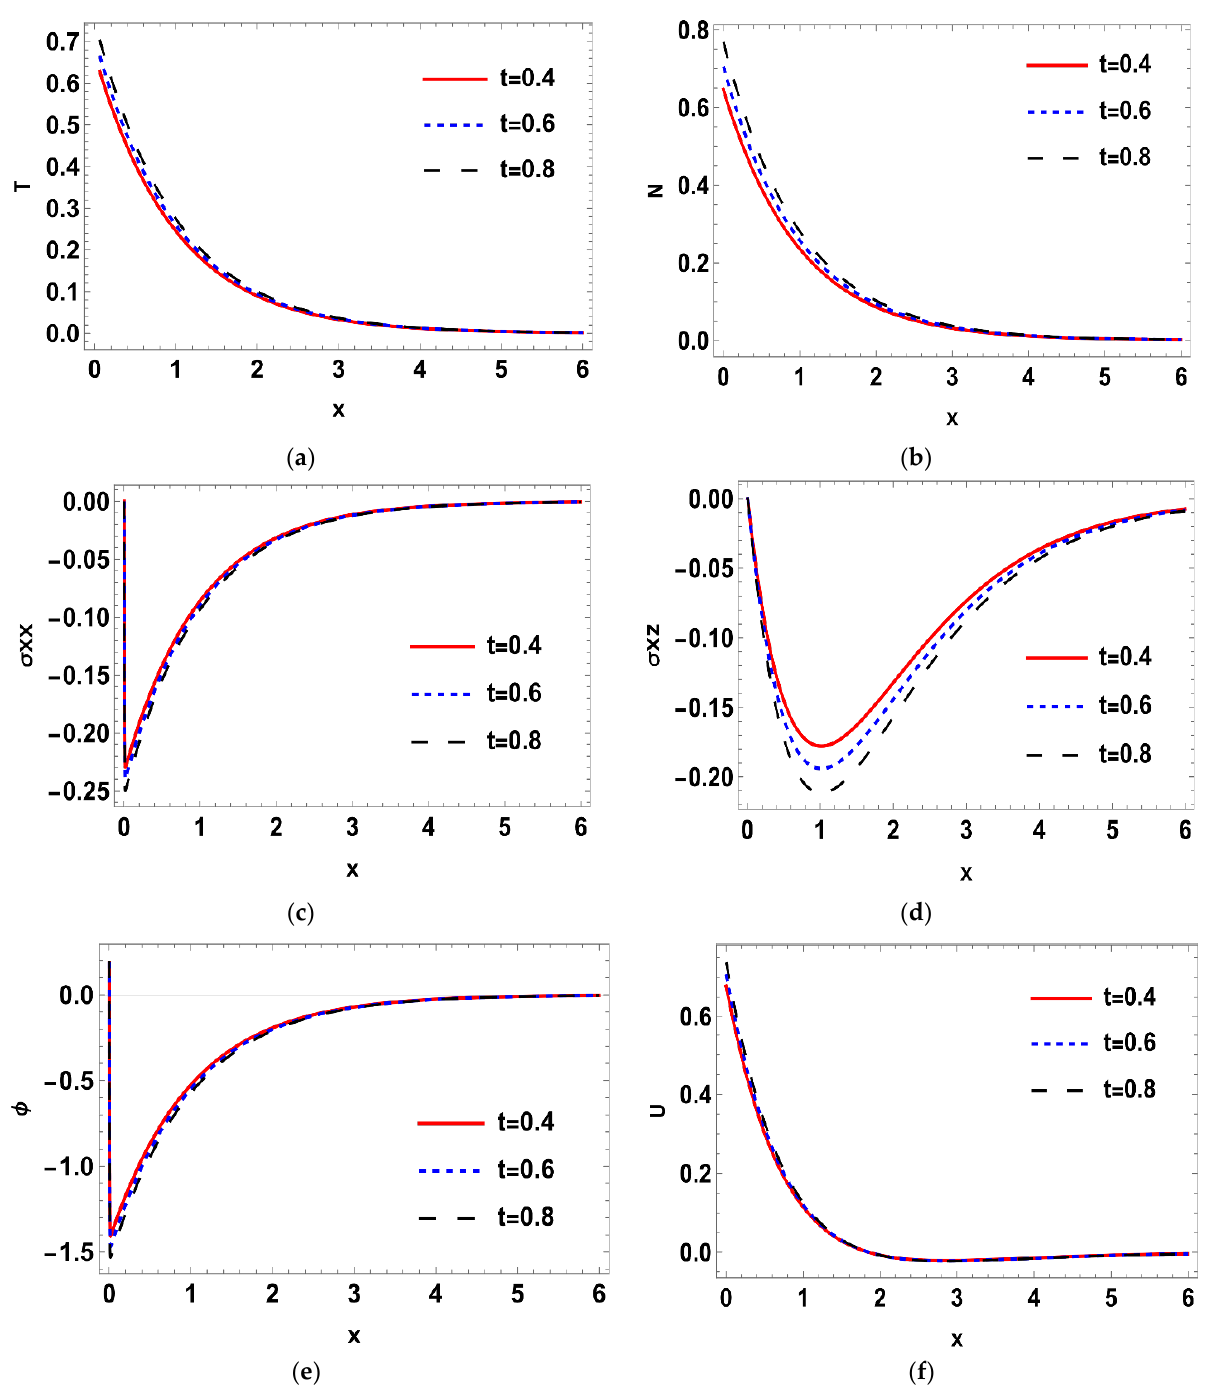
Figure 4. ( a – f ) The deterministic temperature, normal stress, carrier density, displacement and heat conduction distributions along the distance for various values of times in relation to generalized photo-thermoelasticity theory. when 0 a = .